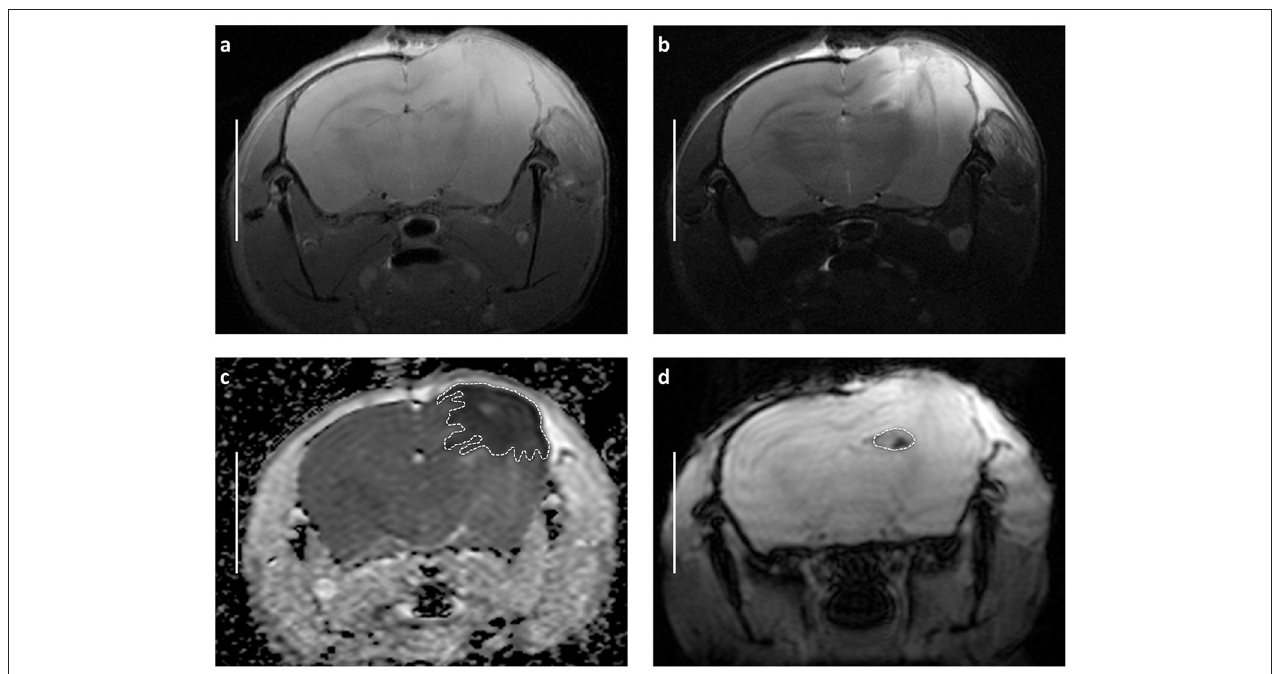
FIGURE 2 | Demonstrating main radiological features of decompressive craniectomy in closed head injury model and approach for volumetric assessment of MRI images basing on representative scans obtained 24h after trauma and craniectomy (CHI + DC group). (a) T1-weighted image (b) T2-weighted image (c) Appartent diffusion coefficient (ADC) weighted map. The dashed line defines the area of edema as marked manually by an independent observer. The area measurement on series of slices was followed by calculating of edema volume by defined slice thickness. Note the size and character of swollen region (marked hypointensive area underlying the craniectomy window). These features suggest domination of cytotoxic brain edema involving vast cortical areas after surgical decompression. (d) The same MRI layer presented in T-RARE sequence. Here, the area of hemorrhage is outlined by dashed line. Again, the calculation of contusion volume is performed based on the areas of contusion on single slides and on the slide thickness. Bar =